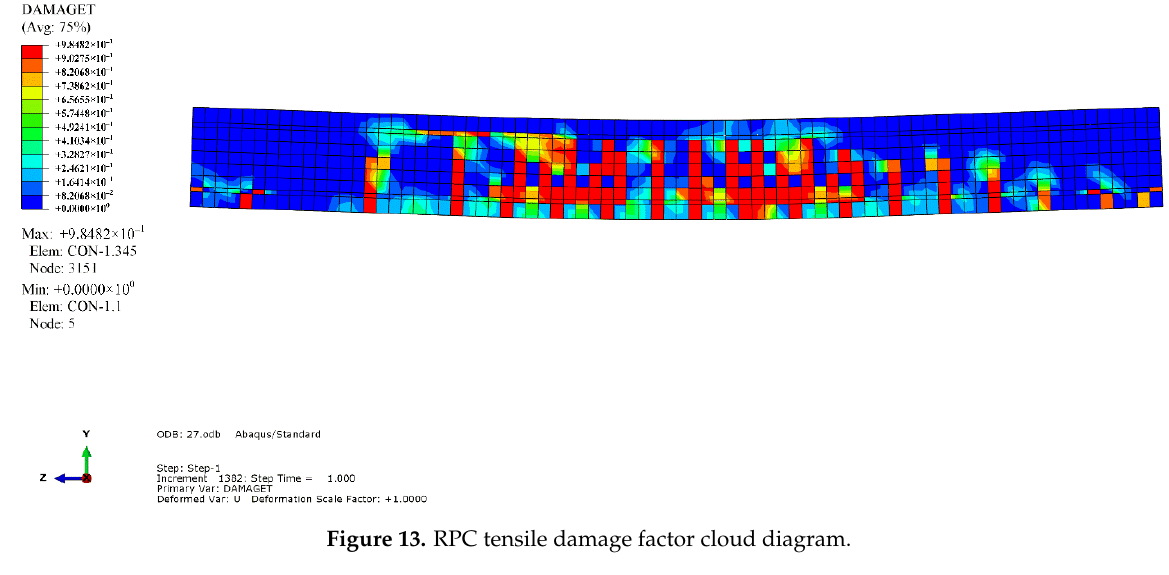
Figure 13. RPC tensile damage factor cloud diagram.